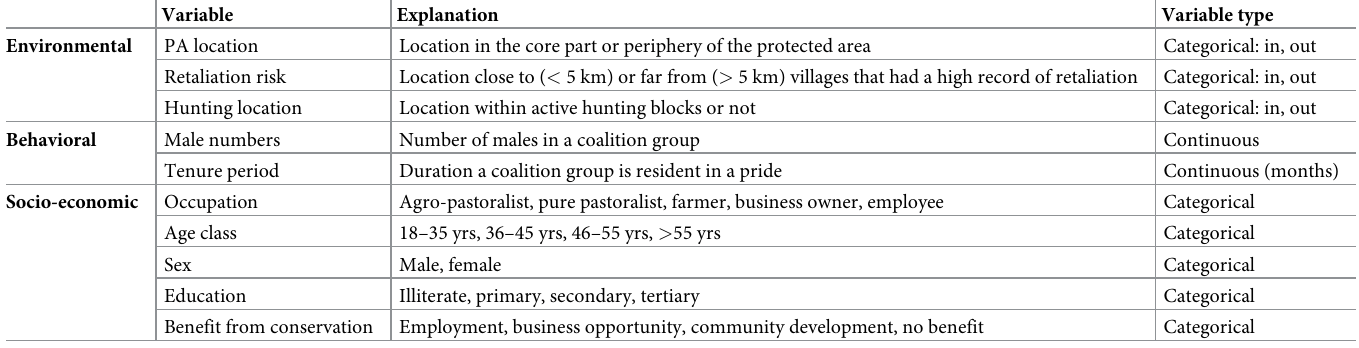
Table 1. Identified variables for determining the effect of retaliatory killing on male coalition and lion population in TME from environmental, behavioral and socio-economic variables respectively in the year